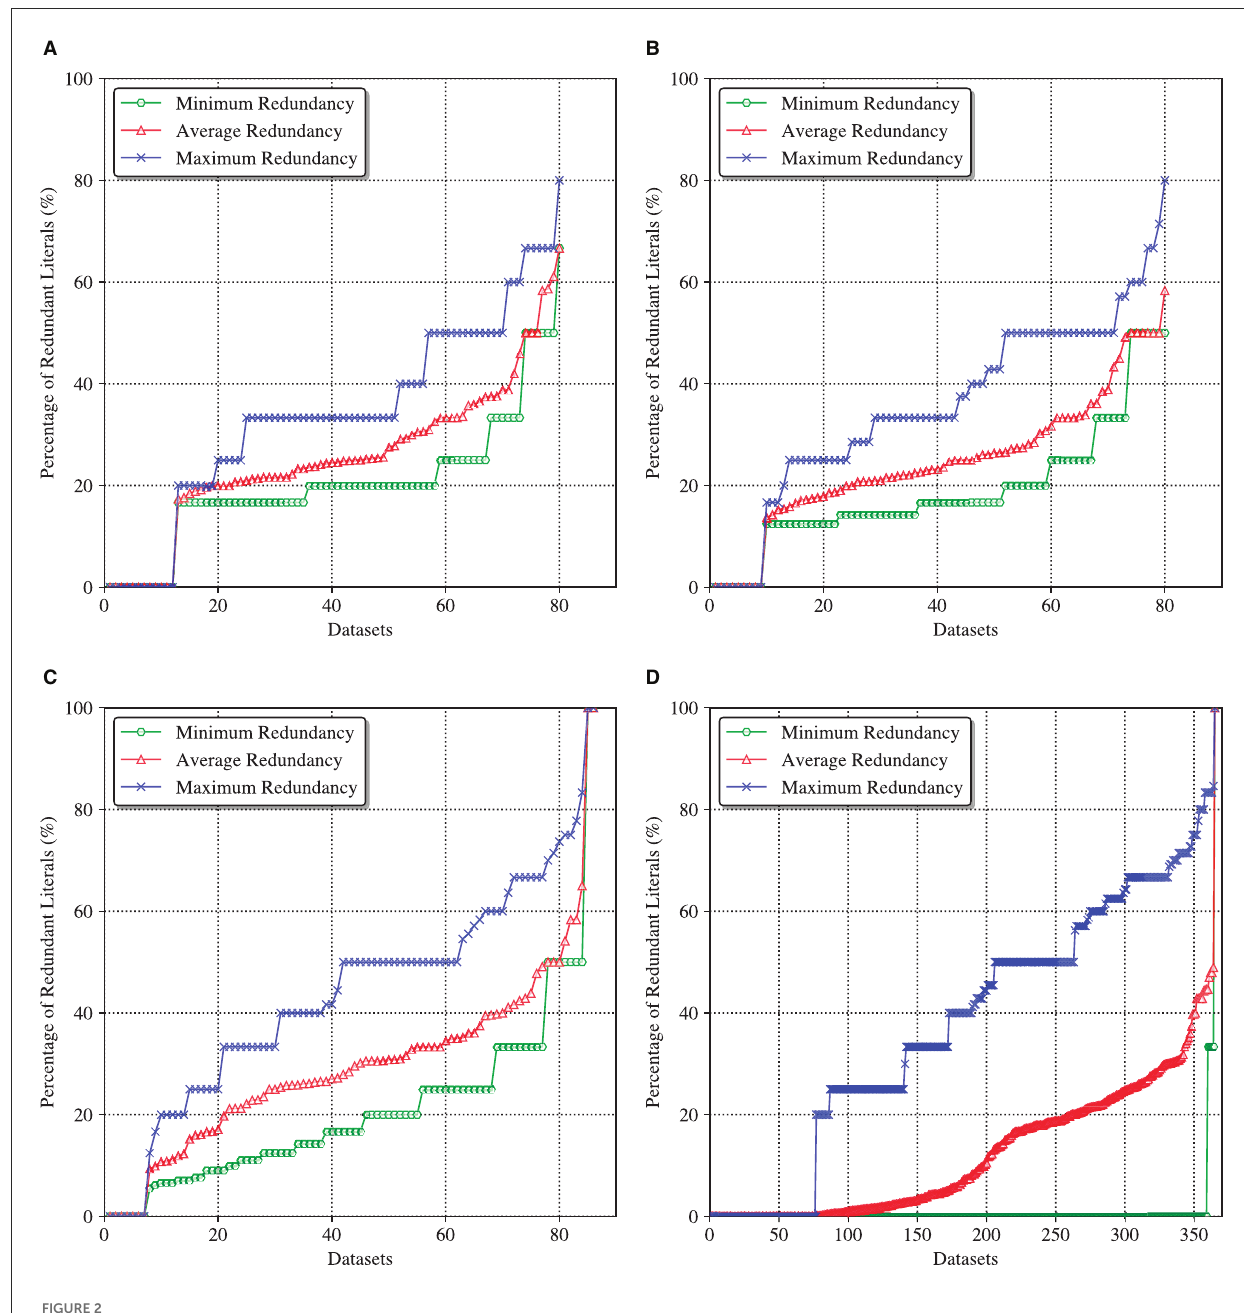
FIGURE2 Minimum, average, and maximum redundancy of default DT and DL explanations. (A) Redundancy of DT/IAI6 explanations. (B) Redundancy of DT/IAI8 explanations. (C) Redundancy of DT/ITI explanations. (D) Redundancy of DL/CN2 explanations.